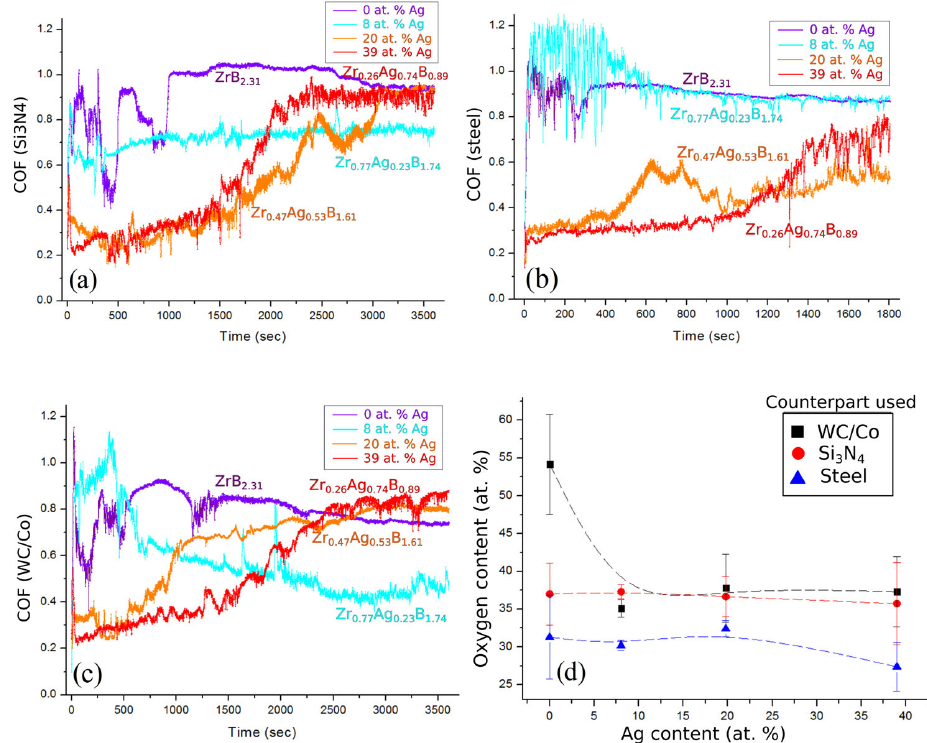
Figure 6. Results of dry sliding ball-on-disc tribological test for the reference ZrB 2+ Δ and Zr 1 − x Ag x B 2+ Δ fi lms on K100 substrate against di ff erent ball materials including ( a ) Si 3 N 4 , ( b ) steel, ( c ) WC/Co). and ( d ) analysis of oxygen content in the wear track areas, where Ag content refers to content in fi lms according to Table